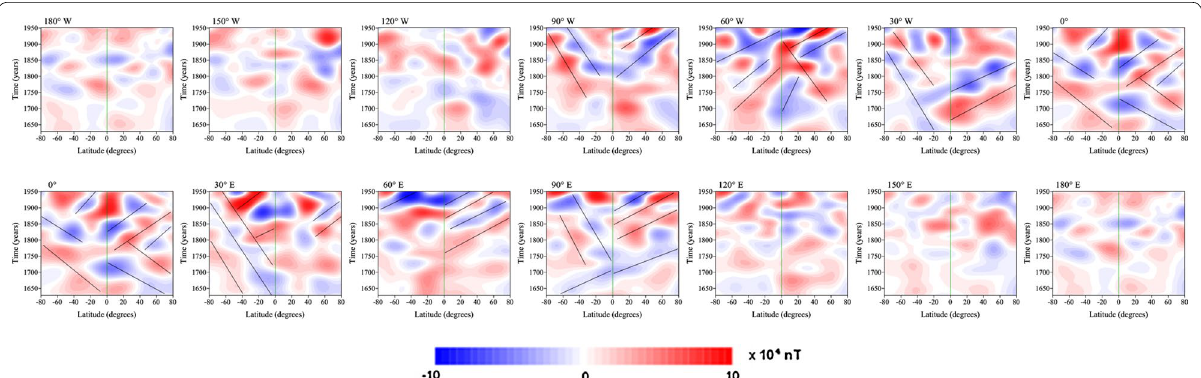
Fig. 4 Time–Latitude plots of the core surface radial component of the sub-centennial constituent for selected longitudes. Vertical green line marks the equator. Movement direction is highlighted by straight line